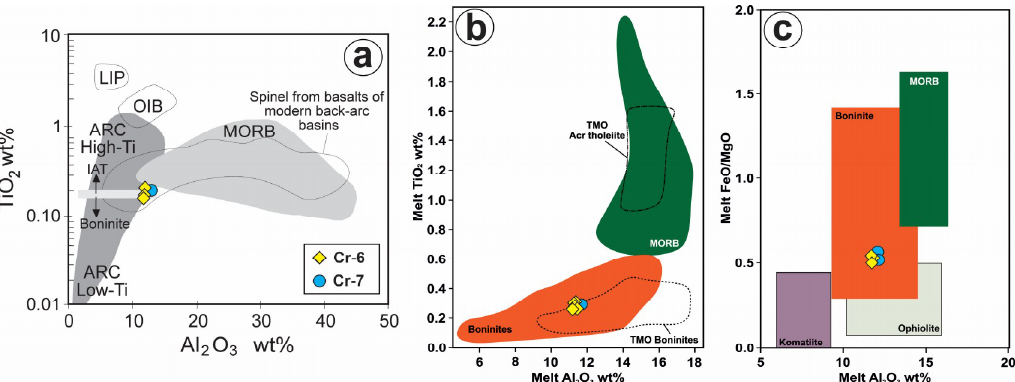
Figure 9. ( a ) Chemical composition of chromite forming the North Andaman chromitites in terms of TiO 2 versus Al 2 O 3 (wt.%); ( b , c ) composition of the parental melt in equilibrium with the studied chromitite in terms of TiO 2 versus Al 2 O 3 (wt.%) and ratio FeO/MgO versus Al 2 O 3 (wt.%) respectively. Data sources for chromian spinel of different tectonic settings are from [64,70,72]. Legend is inset in the figure. Keys for figure (a): LIP (Large Igneous Provinces), OIB (Ocean Island Basalts), MORB (Mid-ocean Ridge Basalts).